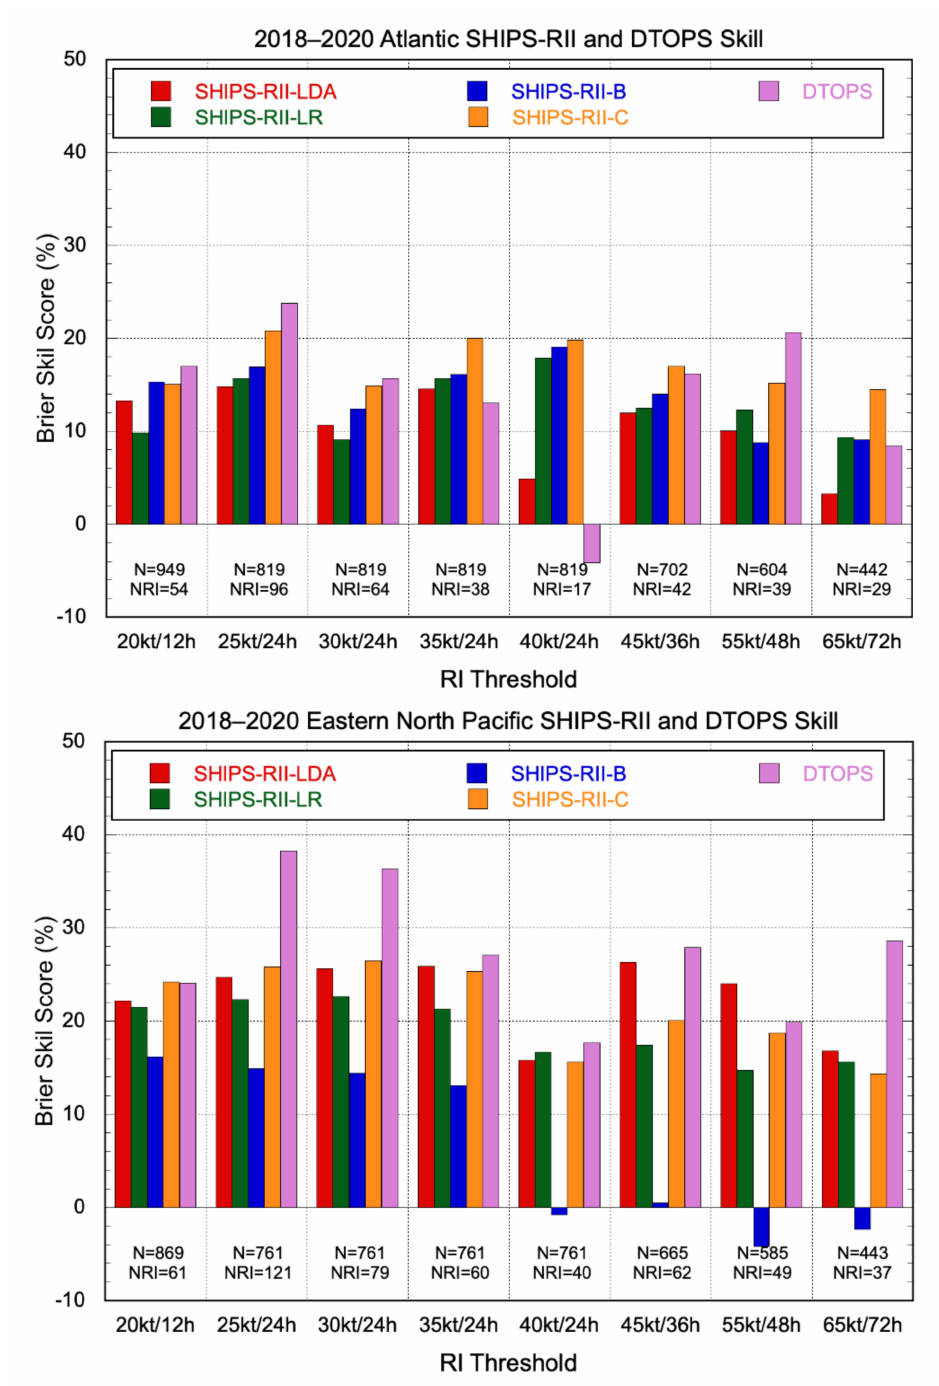
Figure 10. 2018–2020 Brier skill scores for the Atlantic ( top ) and eastern North Pacific ( bottom ) basins for the four SHIPS-RII models and DTOPS. The different RI thresholds are listed below each bar grouping, along with the total number of cases and the number of those cases for which RI occurred. Negative scores depict thresholds for which the model had less skill than